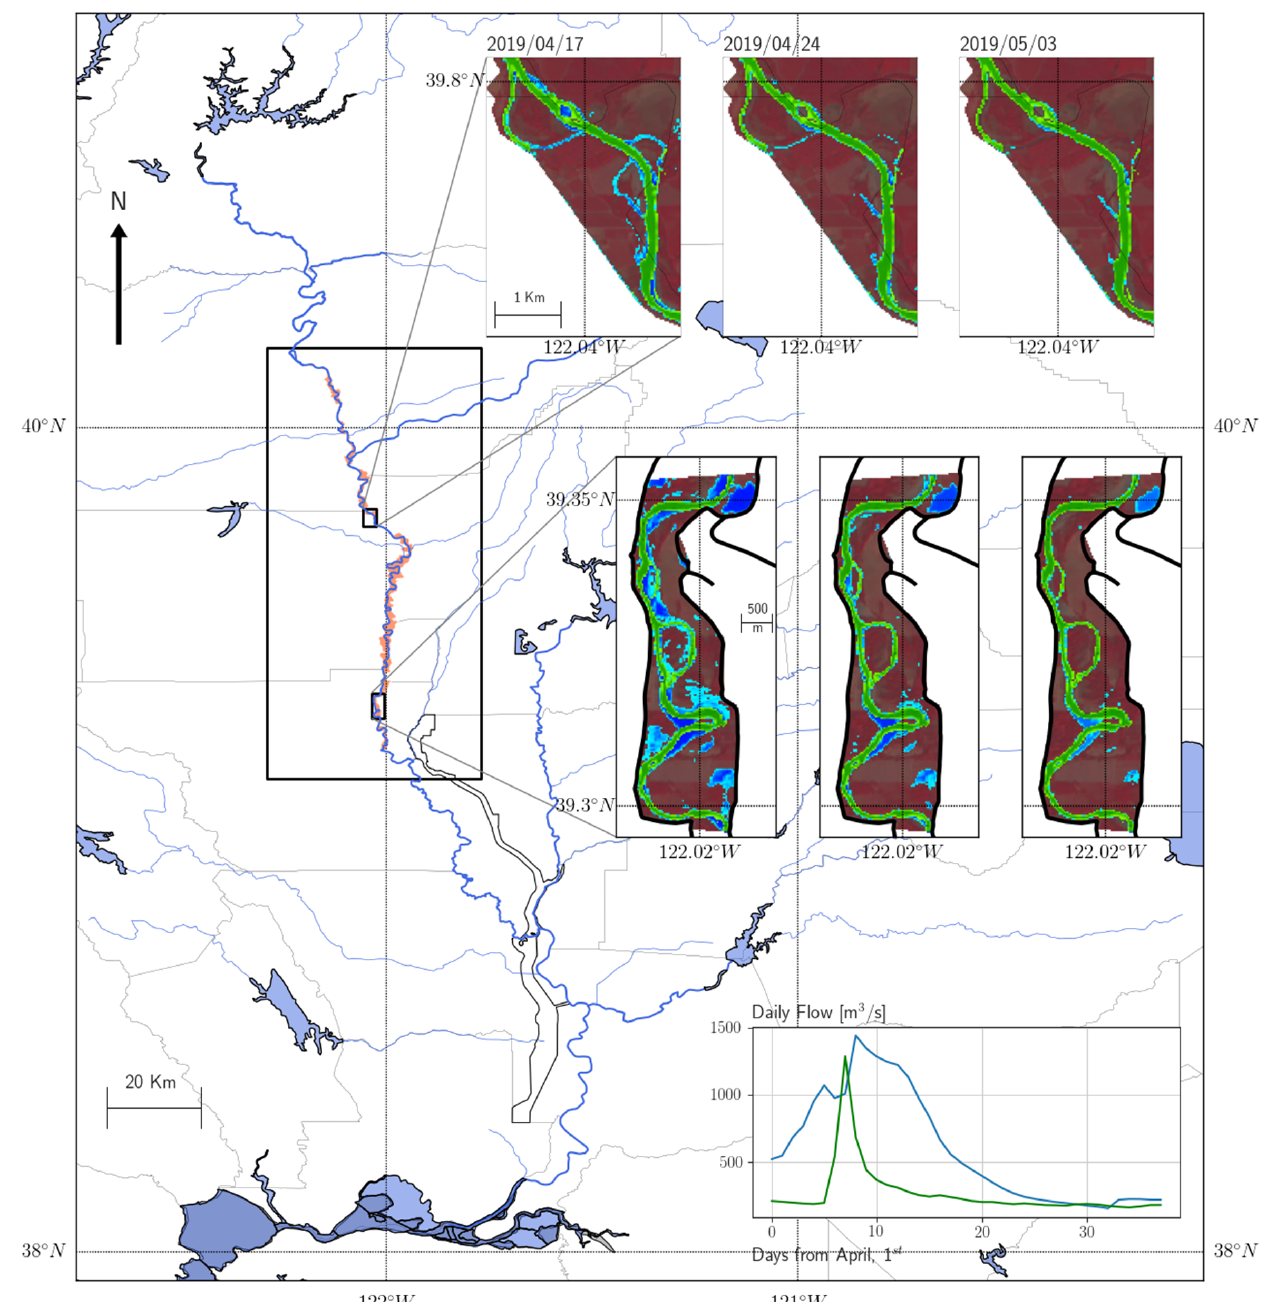
Figure 9. Off-channel inundated areas after 13 March 2016 storm event (hydrograph at bottom right corner) at two specific locations along the study area (black rectangle), extracted from LandSat-8 images using mNDWI with a single threshold (mNDWI > − 0.08).